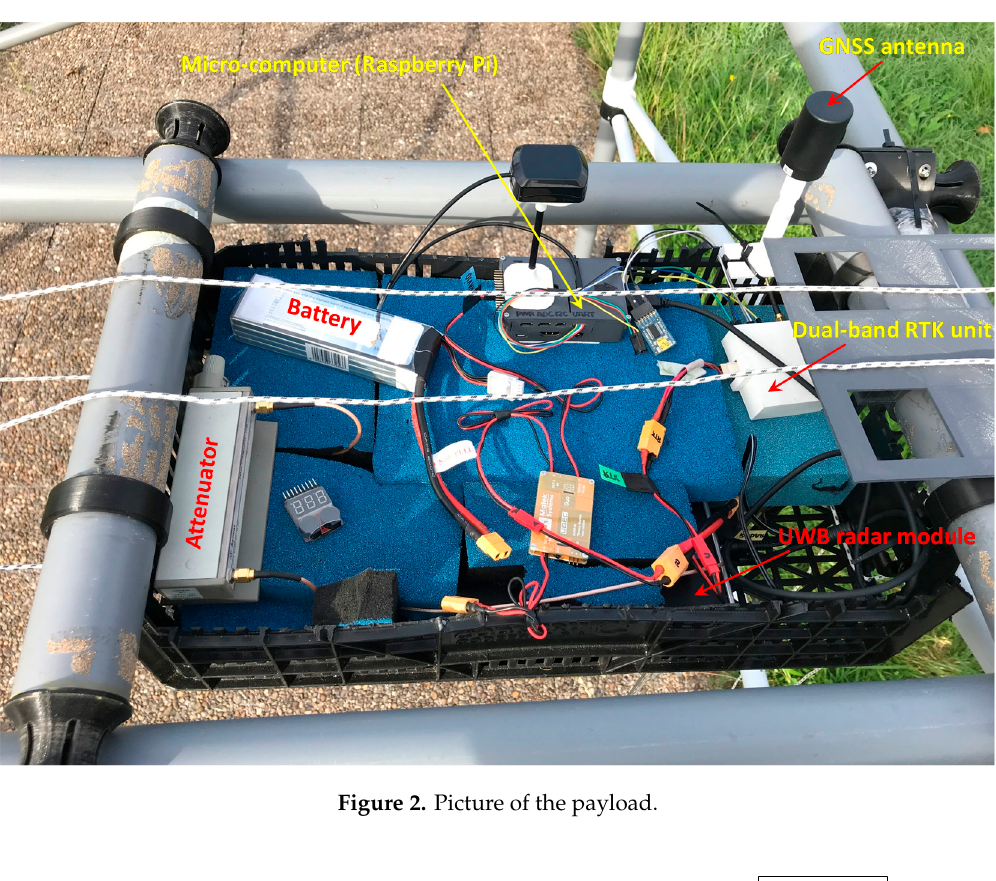
Figure 2. Picture of the payload.